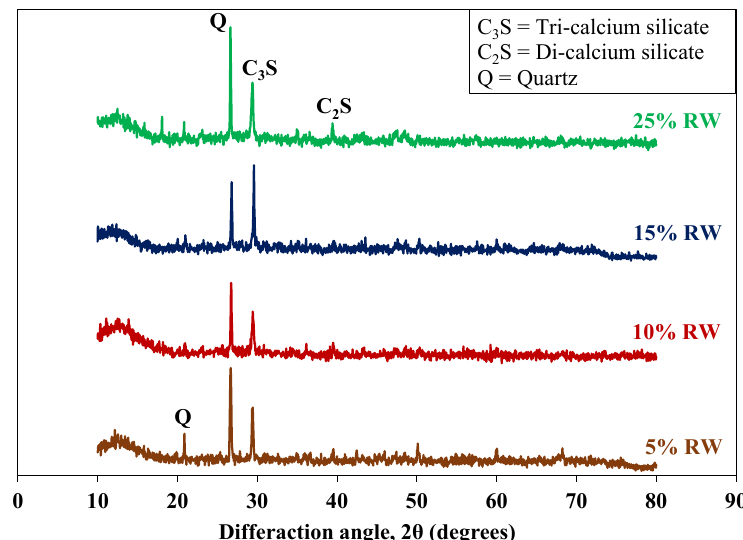
Figure 13. XRD pattern for specimens incorporating RW.